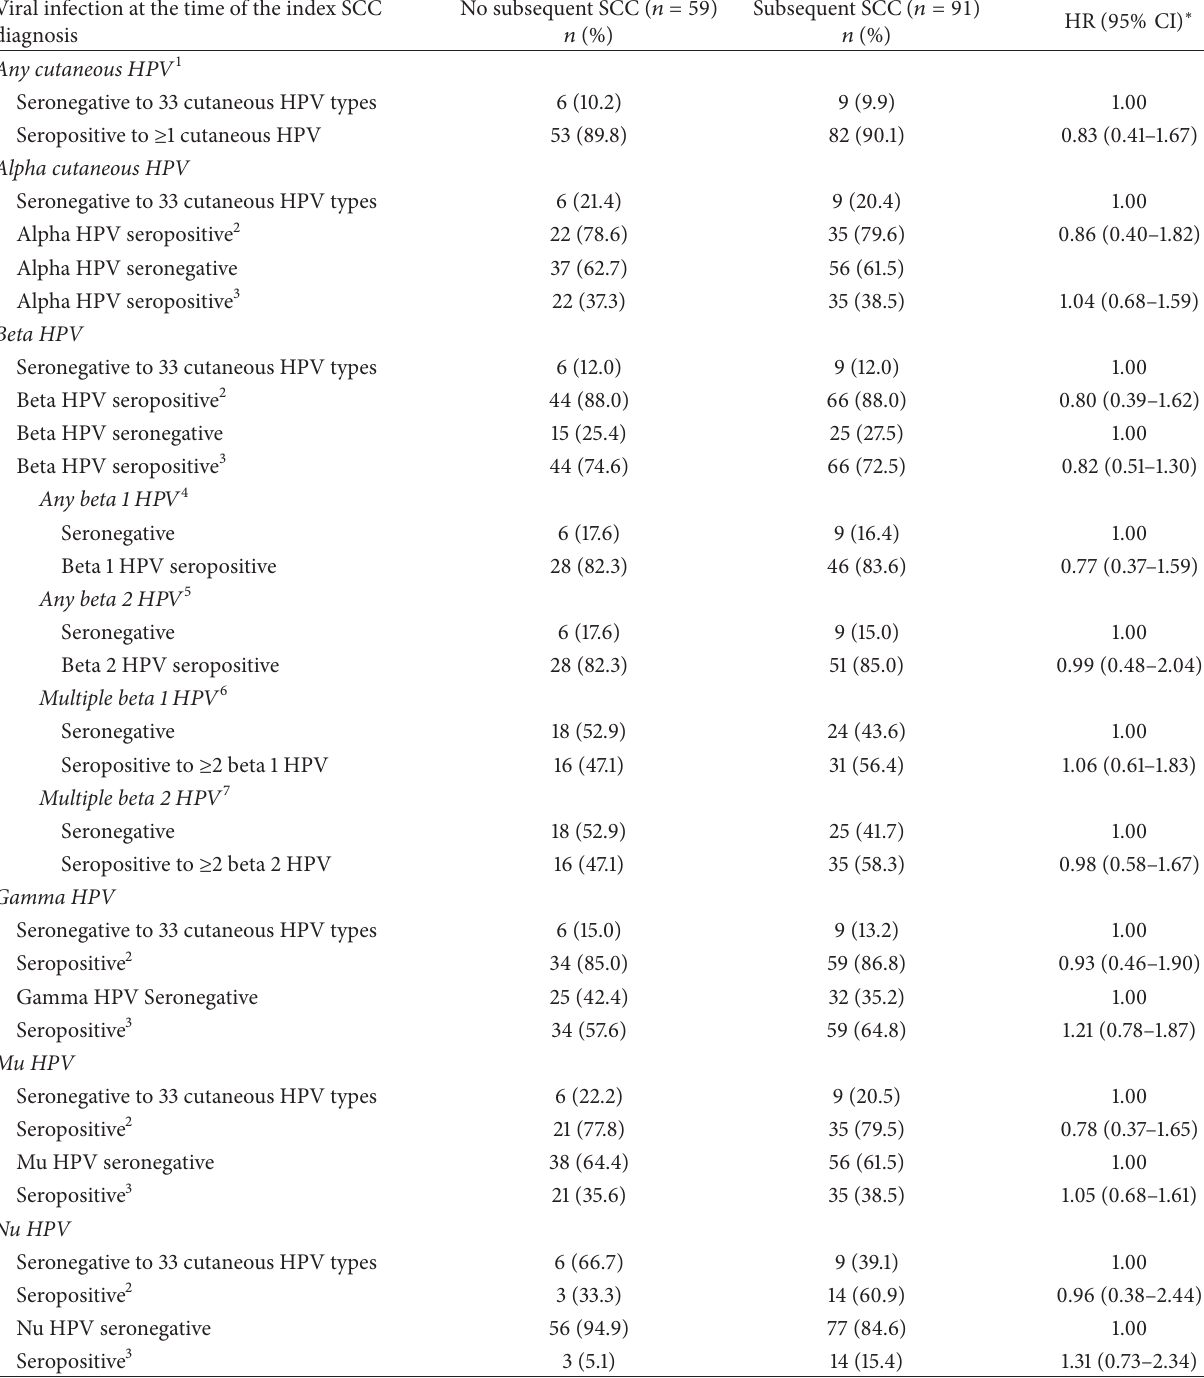
Table 3: Association of seropositivity to cutaneous human papillomavirus (HPV) types at the time of the diagnosis of index SCC and risk of subsequent squamous cell carcinoma (SCC) of the